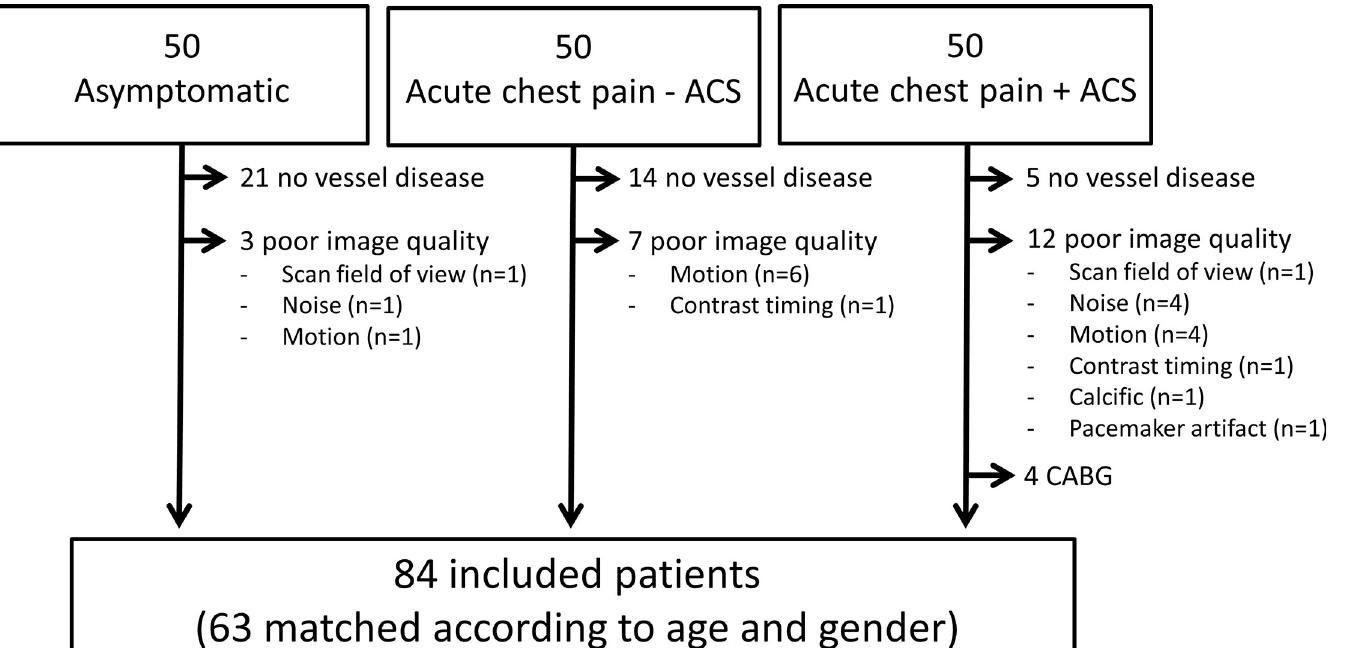
PLOS ONE | https://doi.org/10.1371/journal.pone.0207980 December14,